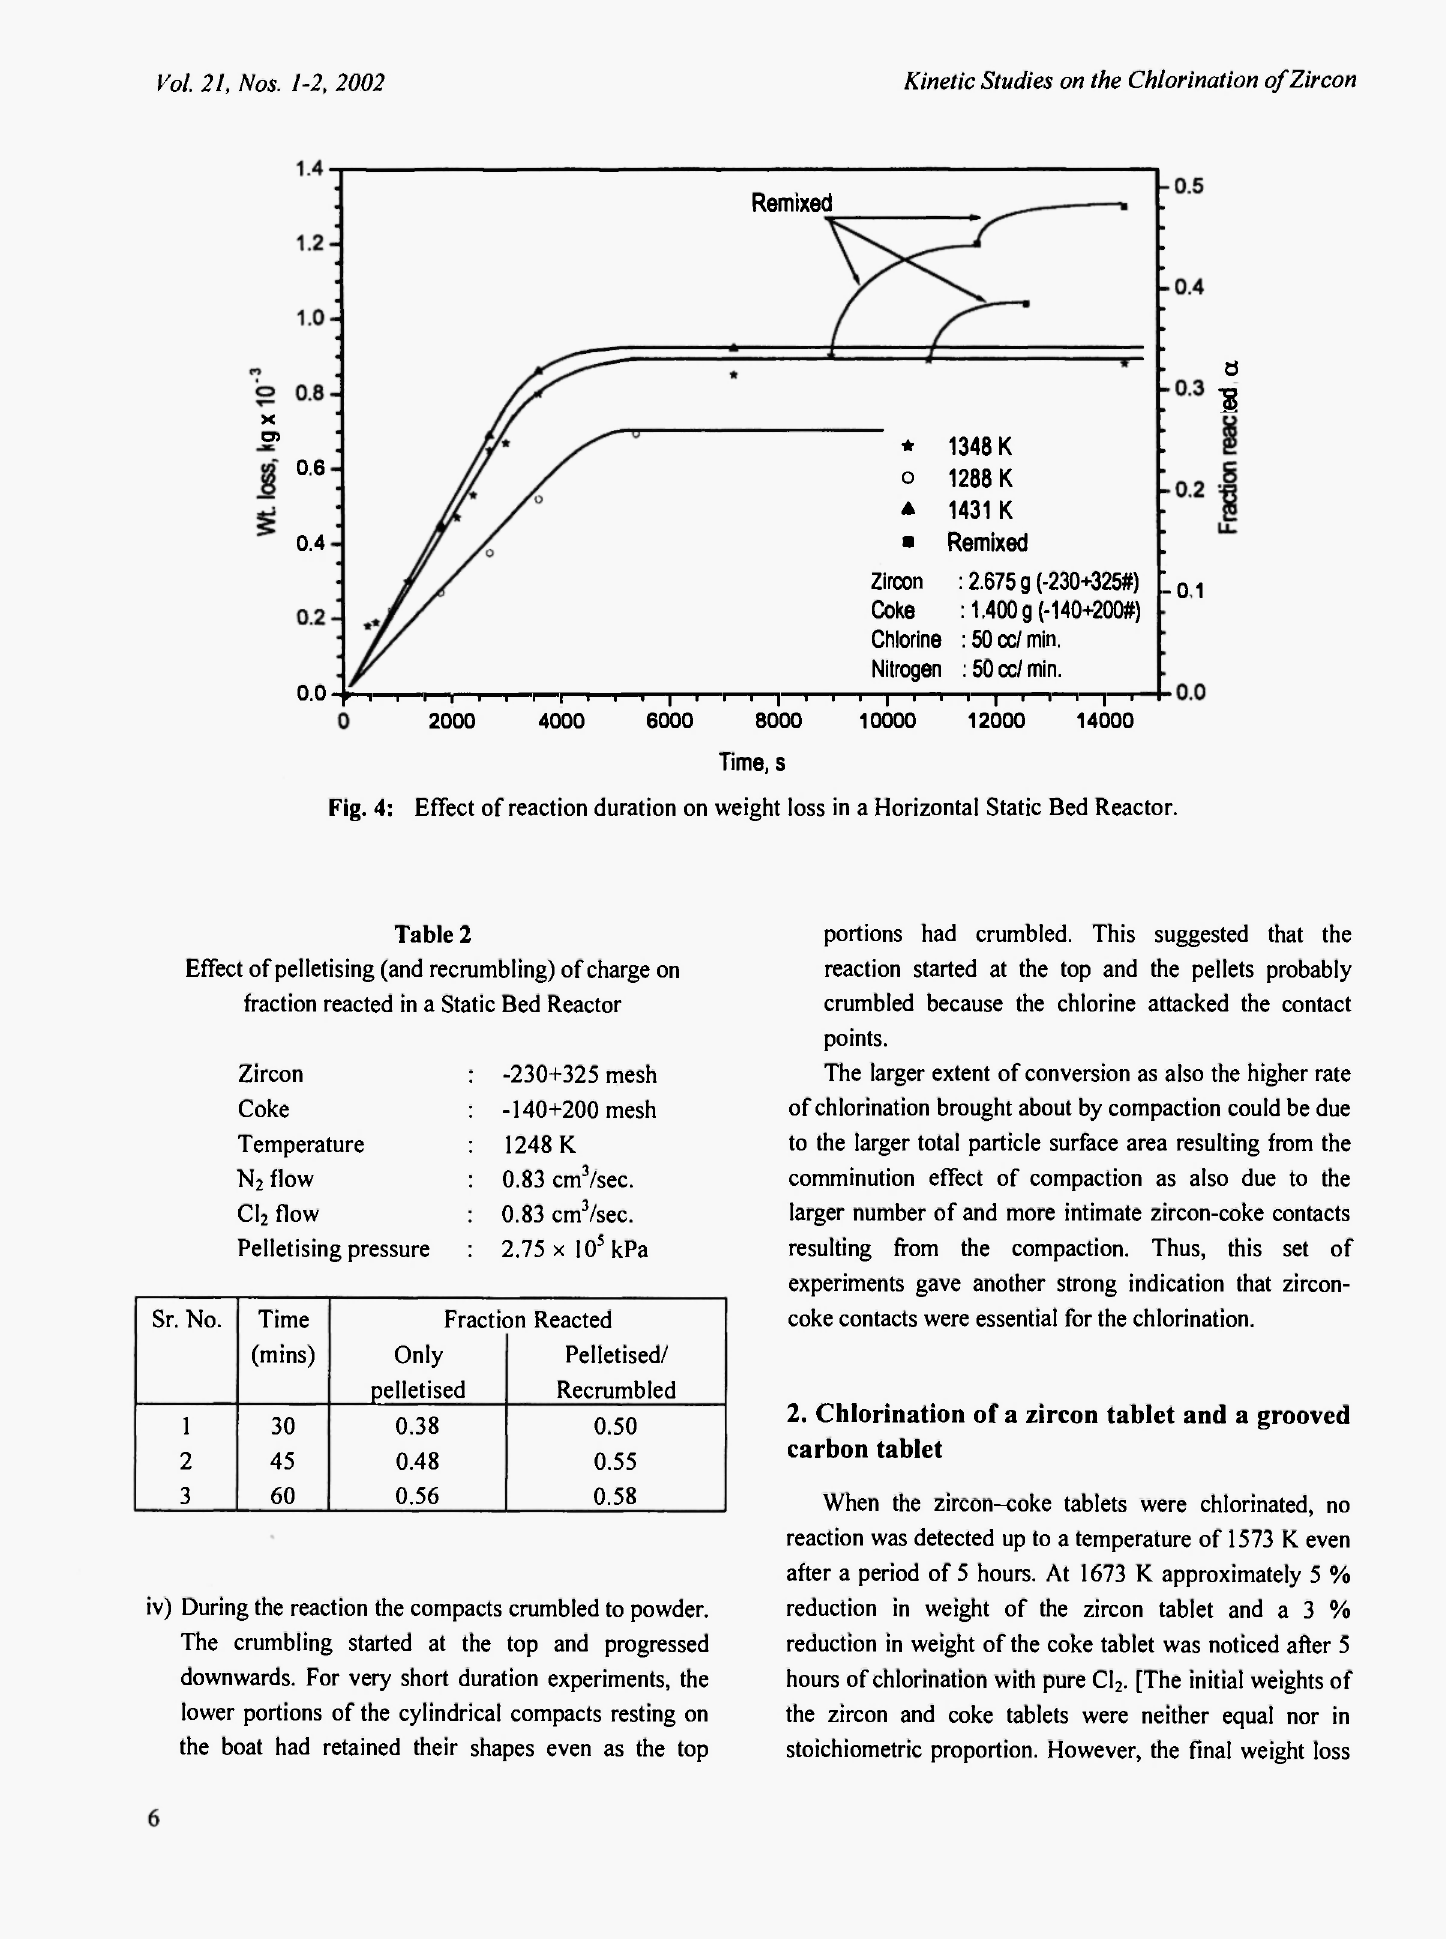
Effect of pelletising (and recrumbling) of charge on fraction reacted in a Static Bed